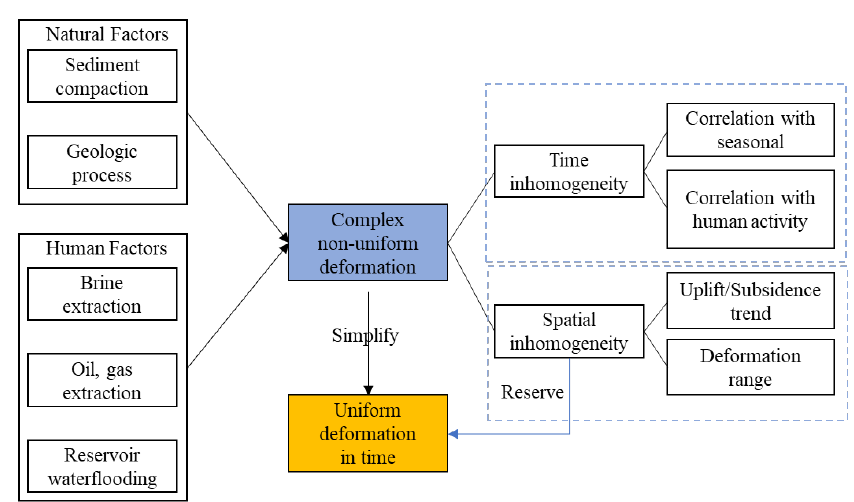
Figure 32. Simplification of surface deformation process in coastal zone.